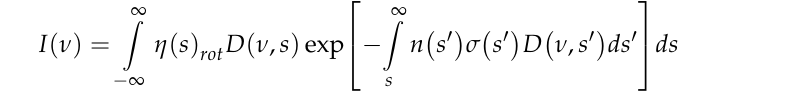
Figure 4. S imulation configurations for the simulated observed spectra. Subgraph ( a ) corresponds to the number density of oxygen, atomic oxygen, nitrogen, and ( b ) corresponds to the tempera- ture, respectively. 3. Inversion Algorithm of Atmospheric Temperature in MLT Lots of atmospheric composition information can be retrieved from the observed O 2 A -band night glow spectra, such as the atomic oxygen profile and temperature profile in MLT. The inversion is realized by inverting the radiative transfer equation, that is, the forward model. Nevertheless, the inverse problem is generally non-linear and ill-posed, so it is impossible to perform the inverse operation for the non-linear model directly. In this paper, the optimal estimation method, the least squares method, and the peak relative intensity ratio method commonly used in the inversion of atmospheric temperature are, respectively, adopted to match the optimal algorithm for the limb observed radiance pro- file of A -band night glow. 3.1. Pre-Selection of Observation Band and Construction of Observation Vector A total of 113 spectral lines within the O 2 A -band airglow full spectrum are numbered and segmented, and three representative bands including weak, medium, and strong bands are selected, respectively. Table 1 below shows the observed spectra of each band in the field of view of 92 km in Figure 5. The sensitivity of emission line integral intensity to temperature on each band is studied, respectively, which is used as the basis to match the best band for temperature inversion.